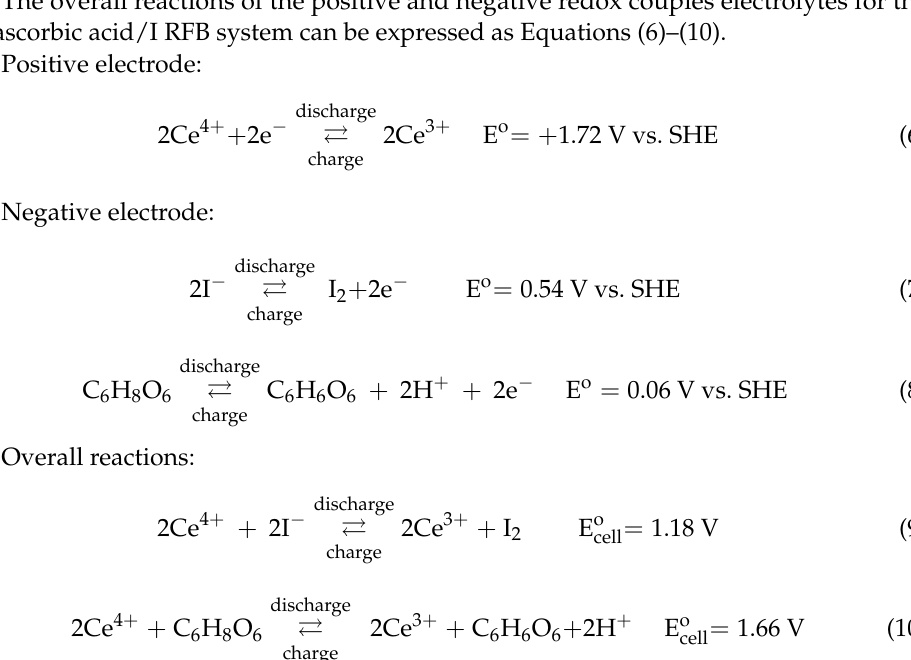
Figure 5. Schematic of the Ce/ascorbic acid/I RFB under a charge – discharge cycle.